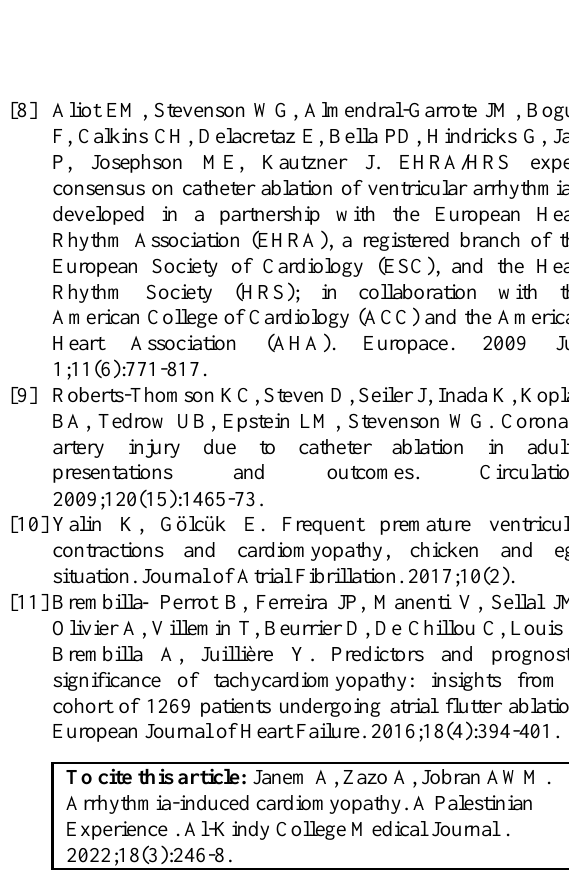
Figure 2: Abnormal ECG showing premature Ventricular contractions (PVCs) in most leads with widespread delta